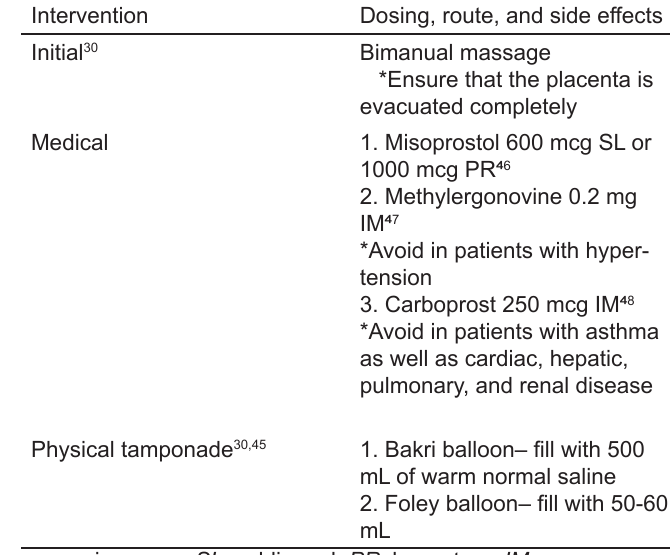
mcg, microgram; SL, sublingual; PR, by rectum; IM, intramuscular; ml,